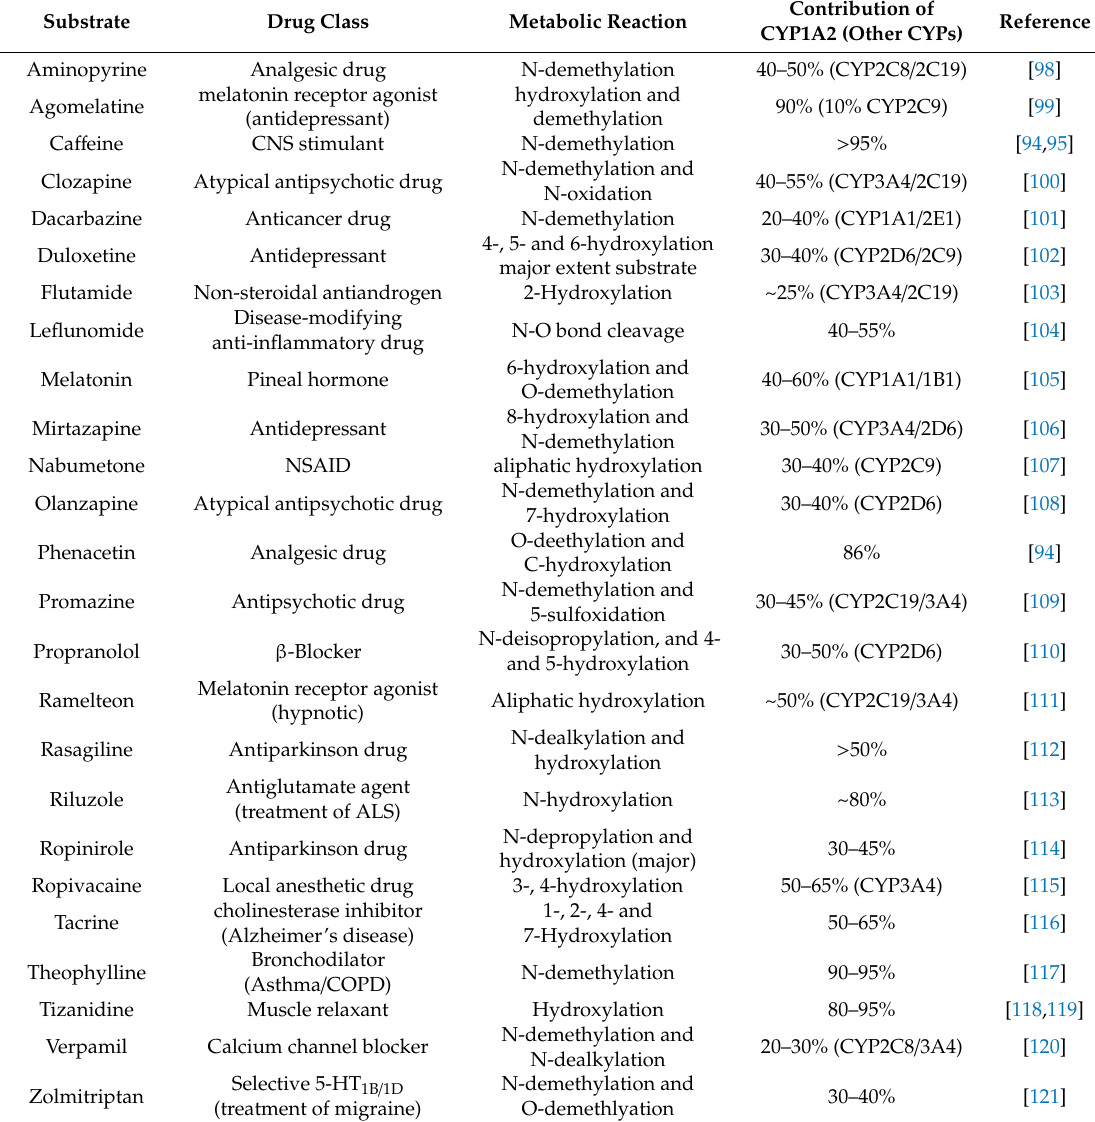
Table3. OverviewforclinicallyrelevantdrugsundergoingsignificantCYP1A2-mediatedmetabolism( ≥